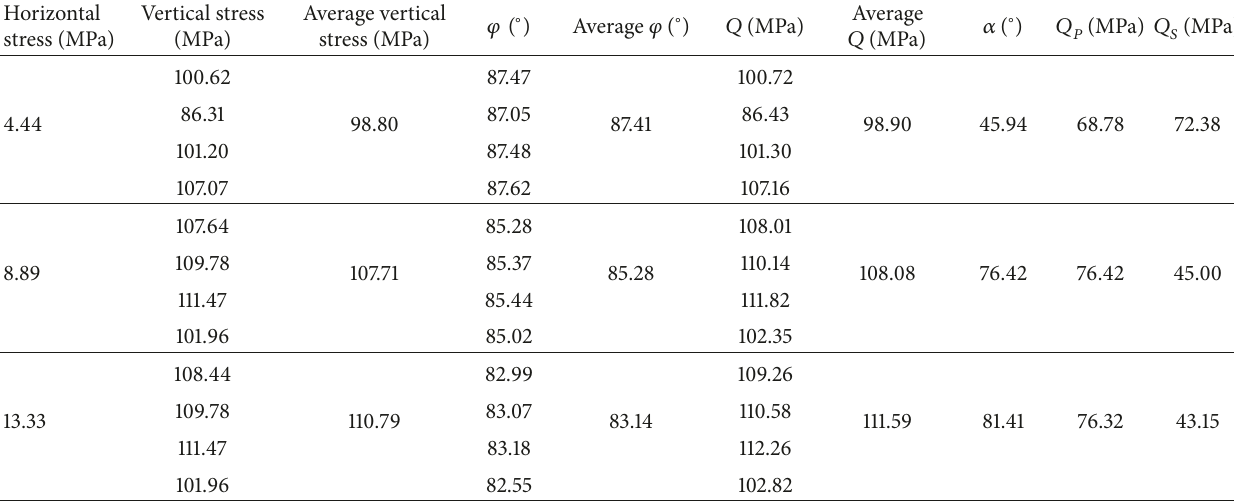
Table 4: Mechanical response characteristics of rock blasting